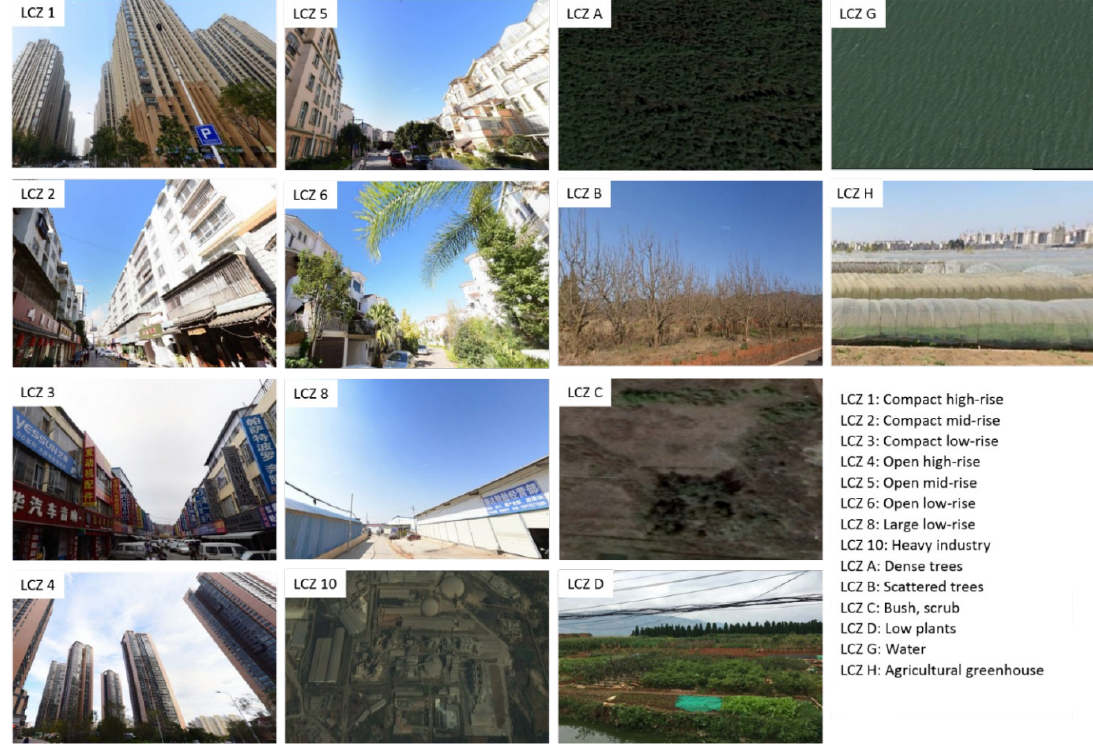
Figure 3. Examples of the different LCZs in